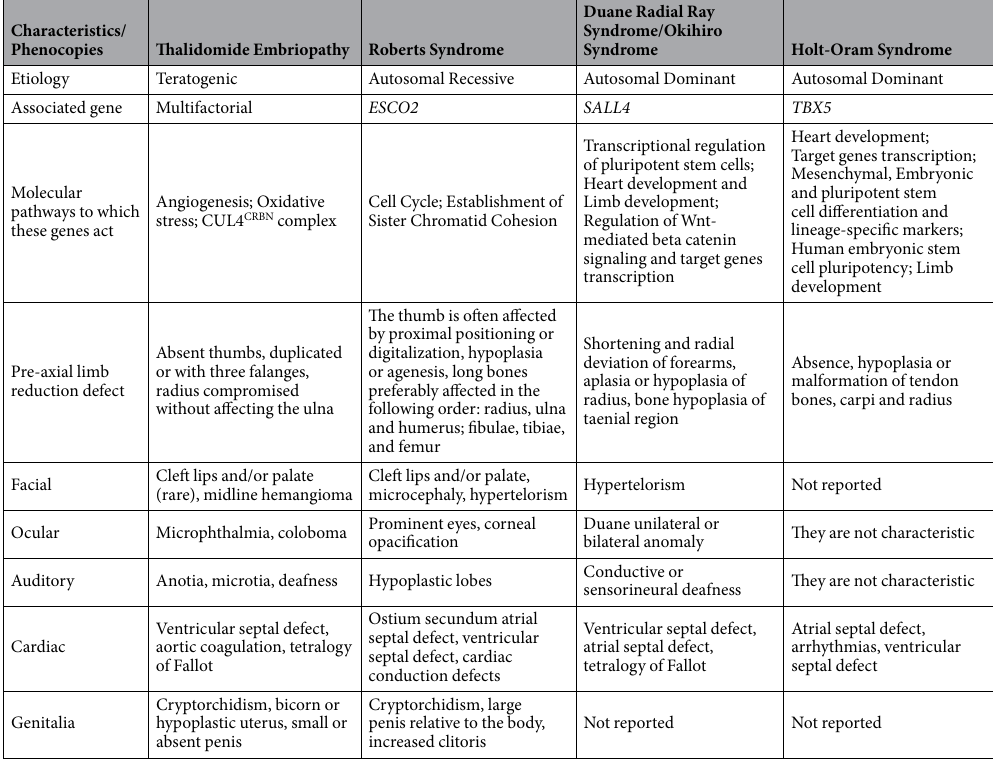
Table 1. Similarities and differences - TE and genetic syndromes. References 3,7,18,31,43–49